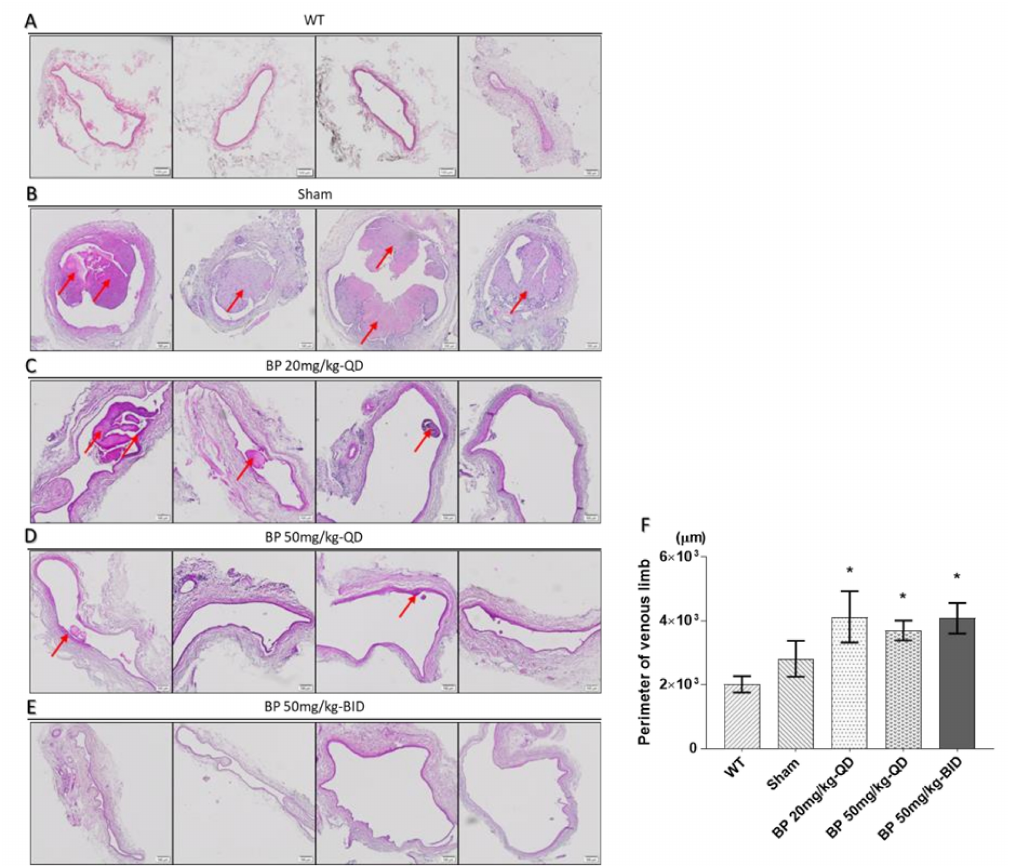
Figure3. Histologicalstainingofavenouslimbofarteriovenousfistula(AVF)30daysafterestablishment, and the comparison of lumen size among rats treated with di ff erent doses of BP. The thrombus and neointimal hyperplasia were indicated by a red arrow. ( A ) WT; ( B ) Sham; ( C ) 20 mg / kg-QD BP; ( D ) 50 mg / kg-QD BP; and ( E ) 50 mg / kg-BID BP. A significant reduction in thrombus and neointimal hyperplasia was observed in rats treated with BP. ( F ) Measurement of lumen size as reflected by the perimeter of the venous limb. Scale bar = 100 µ m. Data are expressed as the mean ± SEM. n = 4 per group. * p < 0.05 versus